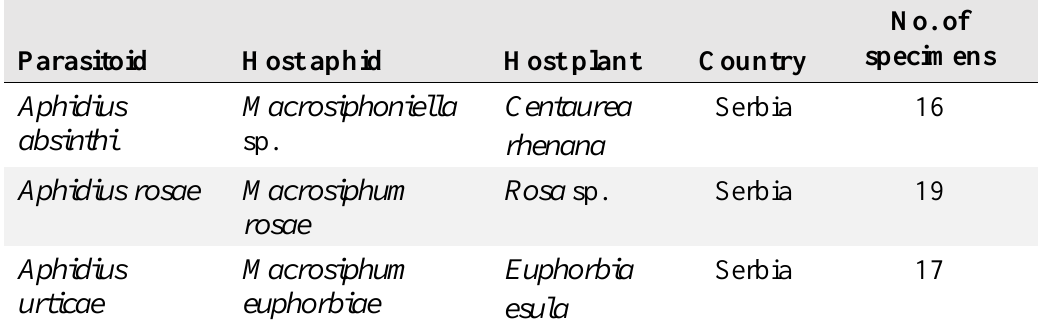
Table 1. List of the Aphidius species used in